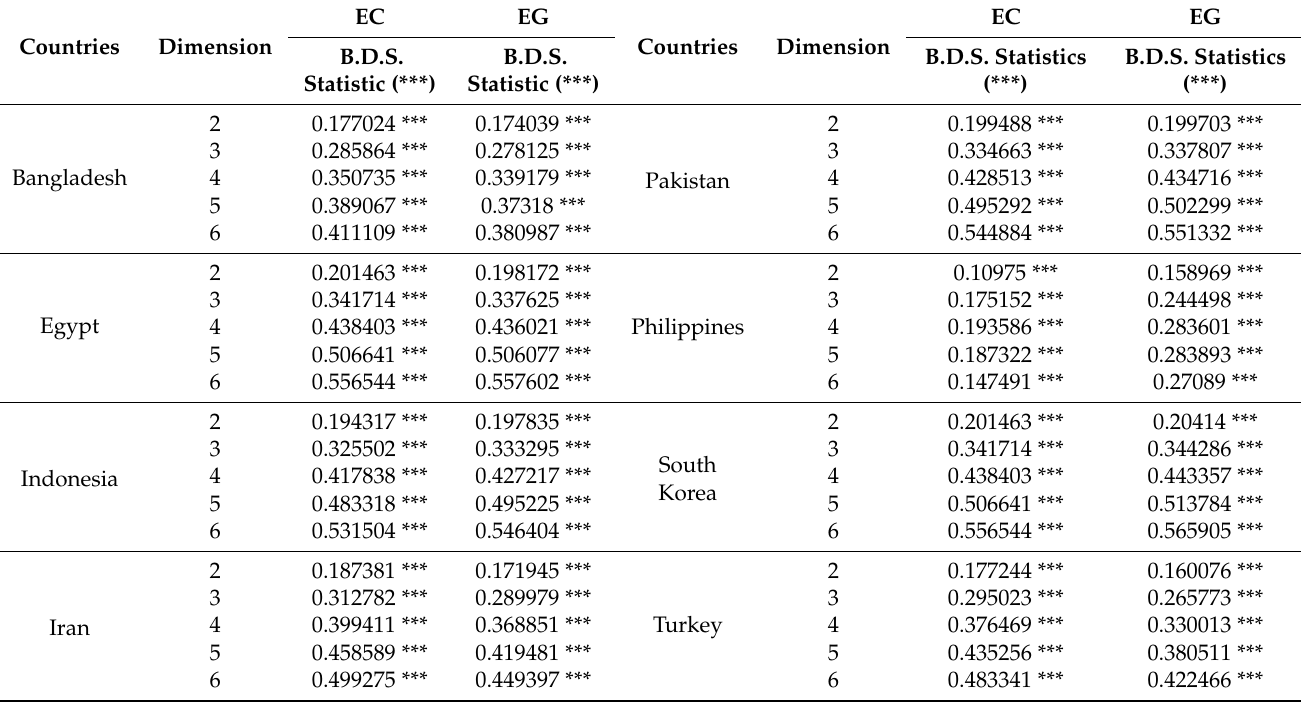
Table 6. B.D.S. test